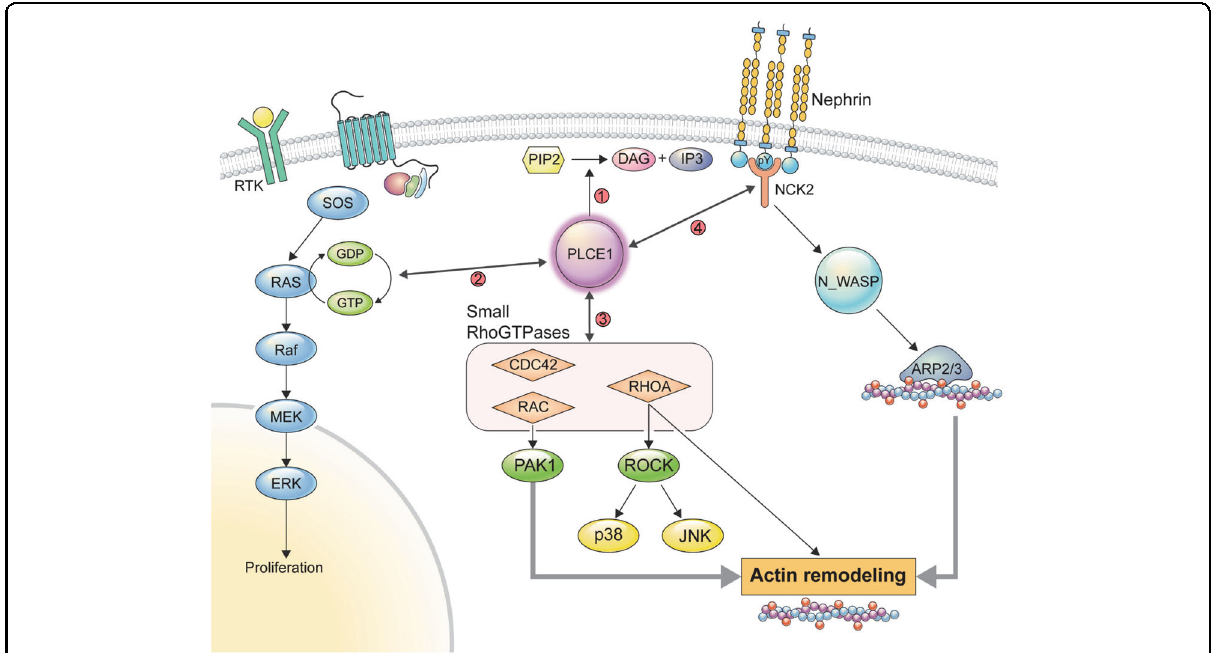
Fig. 7 Functions of PLCE1 in podocytes. PLCE1 plays multiple roles in podocytes: (1) PLCE1 acts as a phospholipase and degrades phosphatidylinositol 4,5-bisphosphate (PIP 2 ) into diacylglycerol (DAG) and inositol triphosphate (IP 3 ). (2) PLCE1 can be activated by a G-protein and transduces mitogenic signals through its RasGEF activity to stimulate the Ras and MAPK pathways. (3) PLCE1 regulates the activity of Rho GTPases, which are the key regulators of actin dynamics and cell migration. Upon loss of PLCE1, the levels of active Rac1 and Cdc42 were reduced. (4) PLCE1 interacts with NCK2, which plays a pivotal role in stimulating N-WASP-Arp2/3-induced actin